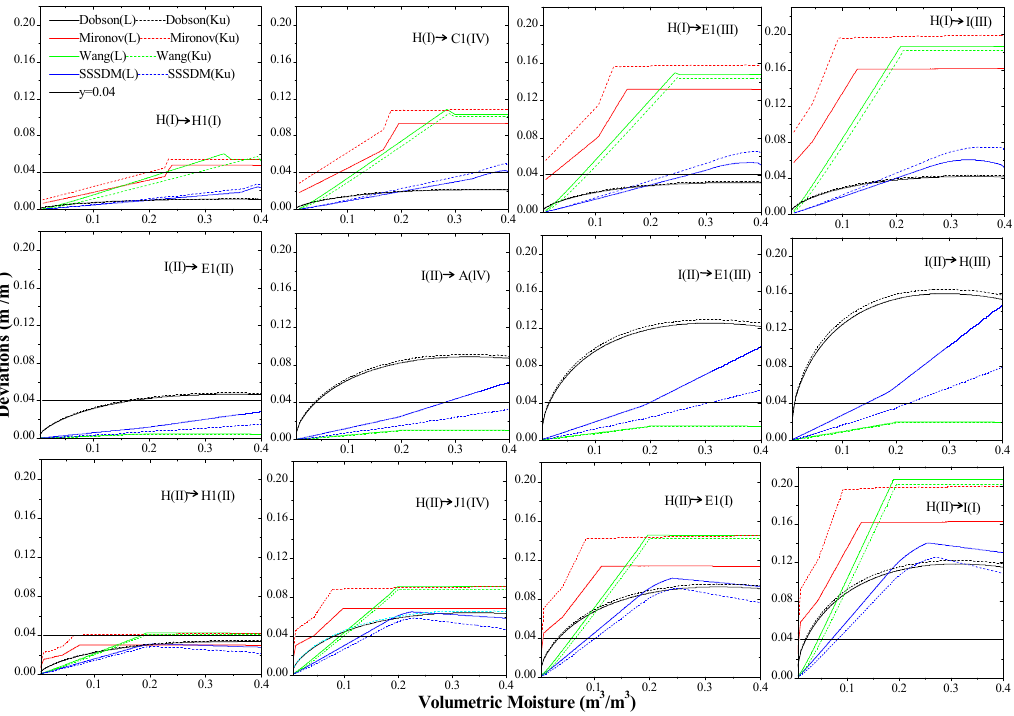
Figure 7. Deviations in the soil moisture retrievals by soil texture. Top panels—sand content constant; middle panels—clay content constant; bottom panels—silt content constant. ‘H(I) → H1(I)’ is the ‘H’ sample from Section I, which is used as the input soil texture for the soil dielectric model to construct the lookup table (LUT). The ‘H1 ′ sample from Section I is the input soil texture for the same soil dielectric model to retrieve the soil moisture.